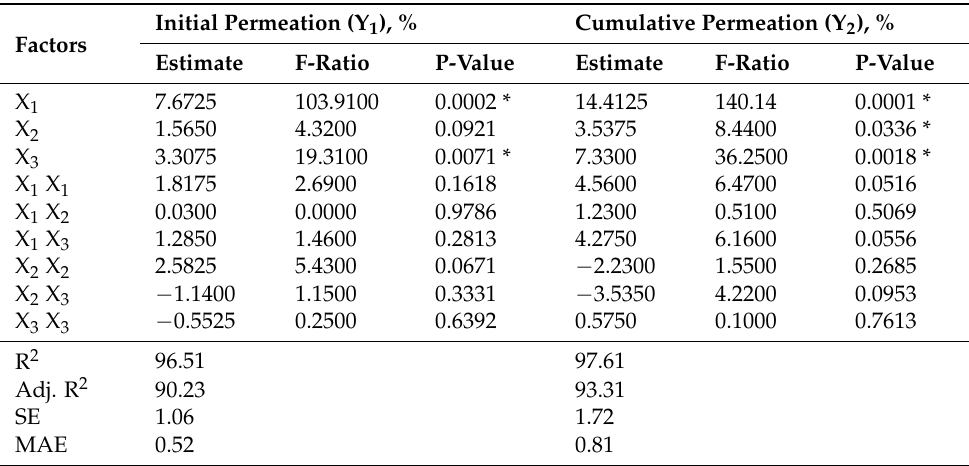
Table 3. Statistical analysis of variance (ANOVA) of the responses (Y 1 and Y 2 )